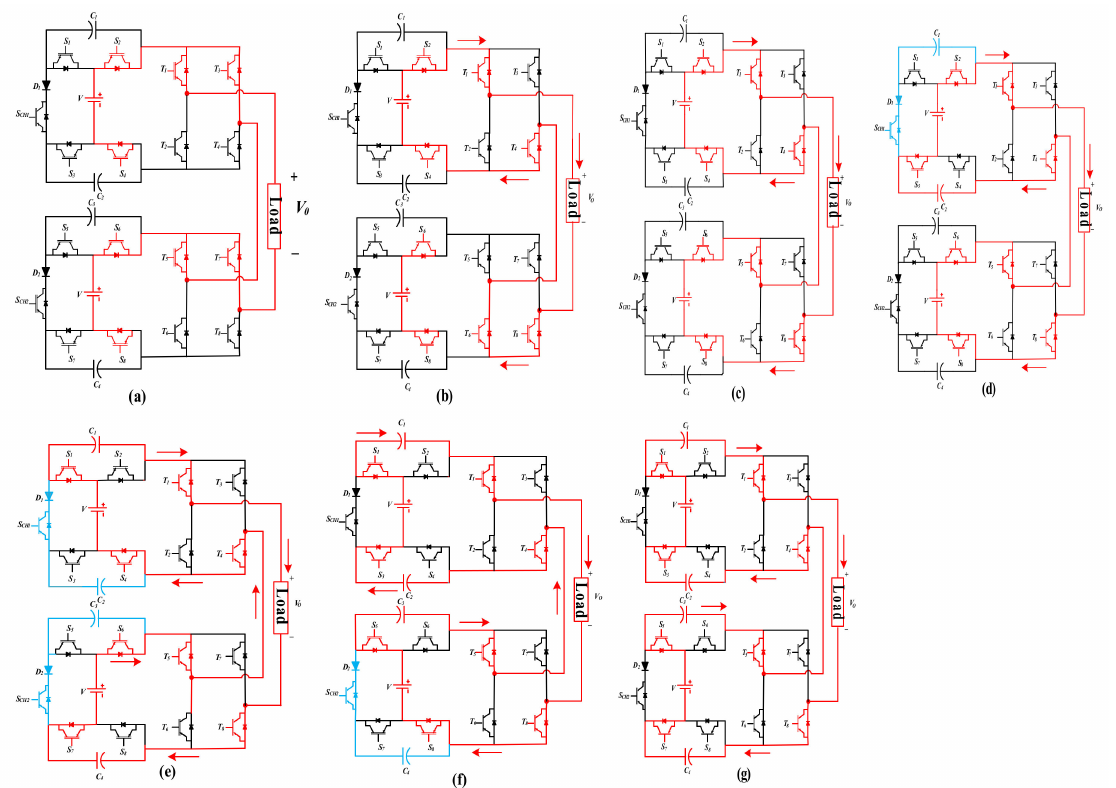
Figure 4. Positive modes of 13 level SCMLI ( a ): Mode 0; ( b ): Mode 1; ( c ): Mode 2; ( d ): Mode 3; ( e ): Mode 4; ( f ): Mode 5; ( g ): Mode